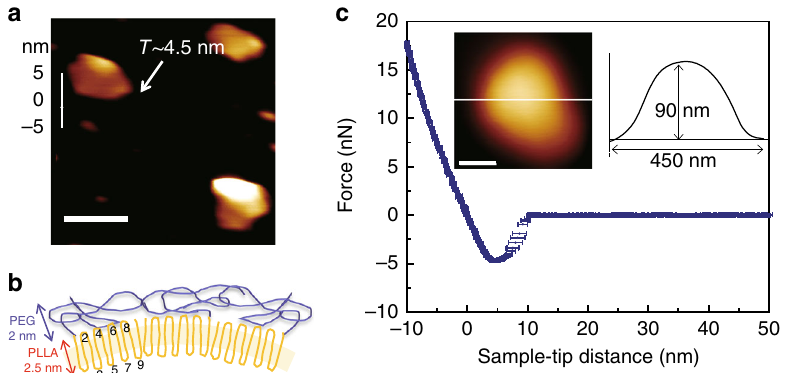
Fig. 3 Mechanical properties of PLLA- b -PEG BCCs. a AFM image and corresponding height pro fi le of a small crystal piece broken using ultrasonication; b Side-view of PLLA- b -PEG BCC shell in dried state, showing thickness of individual layer and PLLA chain folding; c AFM force-deformation spectrum on a PLLA- b -PEG crystalsome. Error bars represent standard deviation of sample-tip distances at different forces, n = 14. Inset: AFM image of the BCC used for the indentation test and its height pro fi le. Scale bars are 100